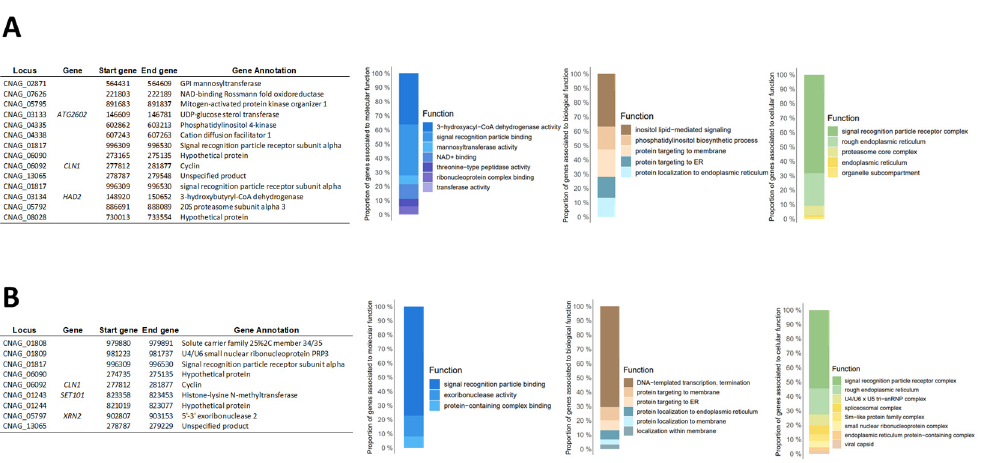
Figure 3. Evaluation of genes with copy number variation (CNV) across VNIa and VNIb sub-lineages. The table shows the genes with CNV shared between the genomes belonging to VNIa ( A ) and VNIb ( B ). On the right, the Gene Ontology enrichment analysis to functional categories (molecular, biological, and cellular) for each sub ‐ lineage (VNIa and VNIb).